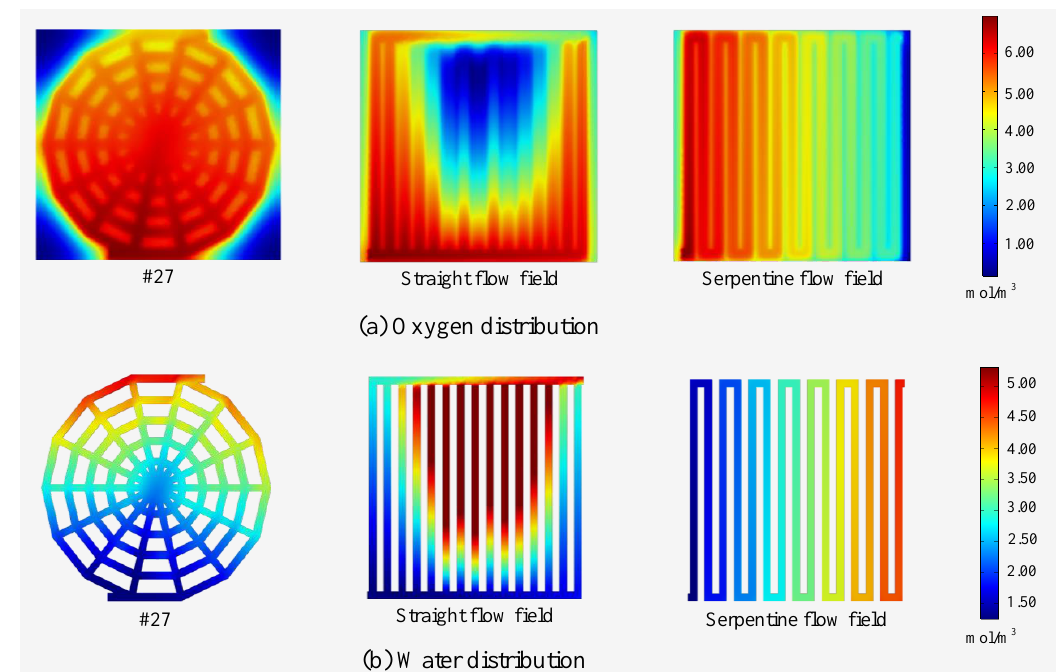
Figure 17. ( a ) Oxygen distribution and ( b ) Water removal performance between scheme #27, Straight flow field and Serpentine flow field.